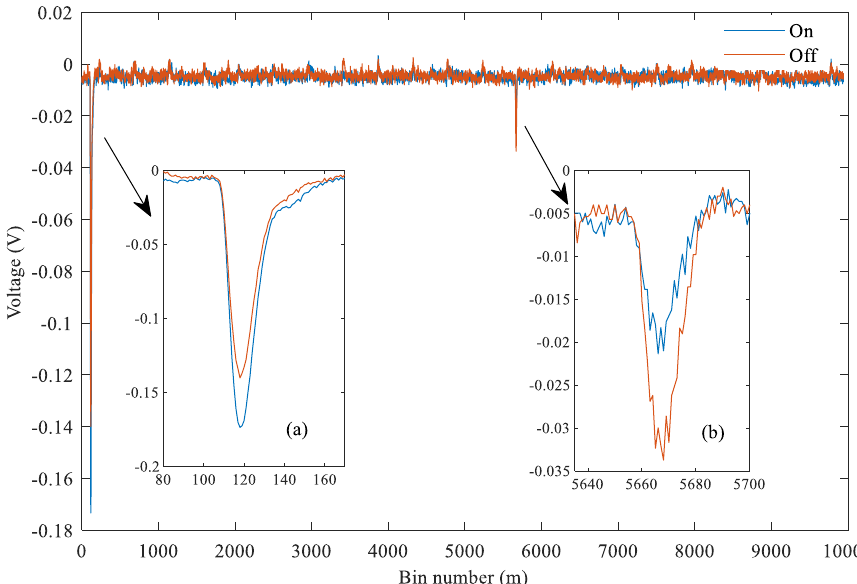
Figure 4. Superimposed on-line and off-line raw signal data. ( a ) Signal waveform shape of the specified proportion saved during the Lidar pulse emission. ( b ) On-line and off-line sea level echo signals.